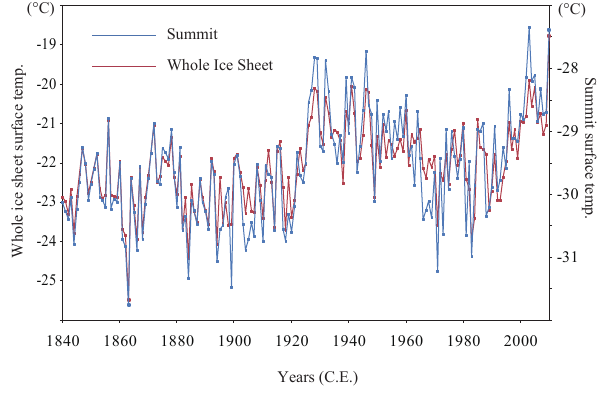
Fig. 2. The Greenland Summit surface air temperature and the Figure 2. whole Greenland ice sheet surface temperature were reconstructed for the last 170yr from a spatial-temporal data fusion between the output of a regional climate model (Polar MM5) (Box et al., 2009) and in situ observations (Kobashi et al.,